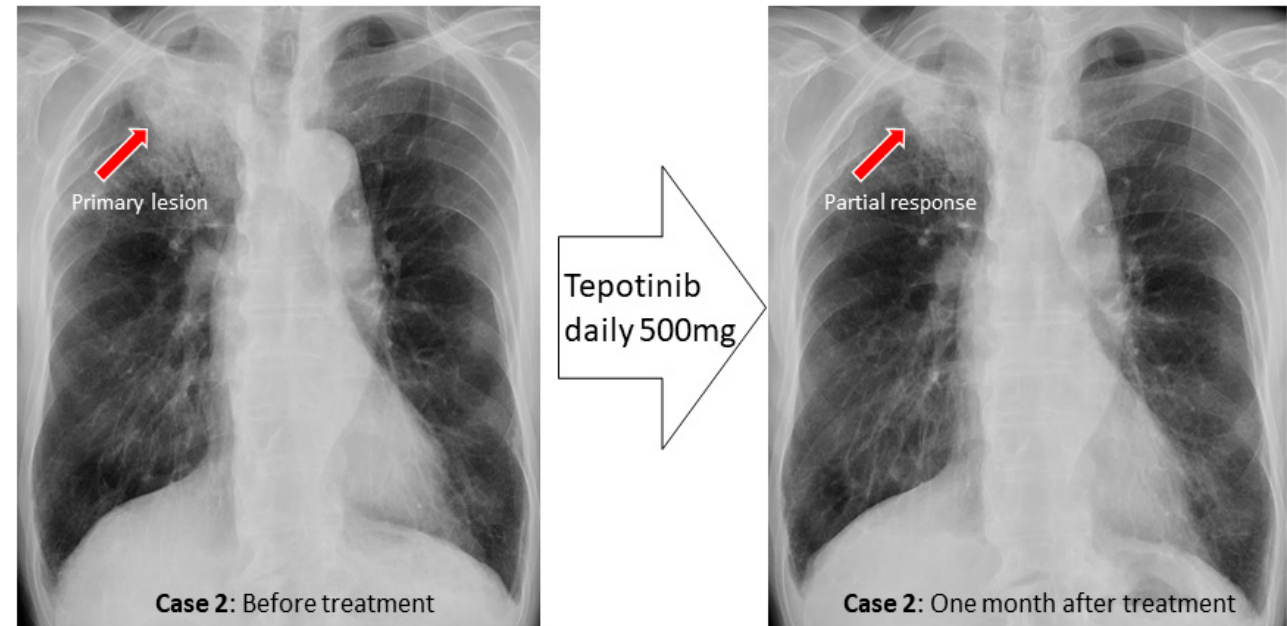
Figure 6. Cases 1 and 2 showed a favorable response after administration of molecular-targeted drugs. Case 3. A male in his 80 s with a smoking history (Brinkman index of 2500), was unintentionally found to have lung cancer by CT scan performed before surgery for an inguinal hernia. A diagnosis of class V adenocarcinoma was made by sputum cytology. A second sputum sample was collected and bronchoscopy was performed. During bron- choscopic examination, bloody sputum was observed at the right lower lobe where the primary lesion was present. The brushing cytology sample collected from the right B 9 a was submitted for LC-CP, and a diagnosis of adenocarcinoma, cT4N1M0, stage IIIA was determined (Figure 7). Further, a diagnosis of KRAS G12A was detected by LC-CP from the brushing cytology sample (DIN value 9.5, DNA yield 3680 ng, AF 81.9%). This same mutation was detected by LC-CP from the collected sputum sample (DIN value 8.2, DNA yield 684 ng, AF